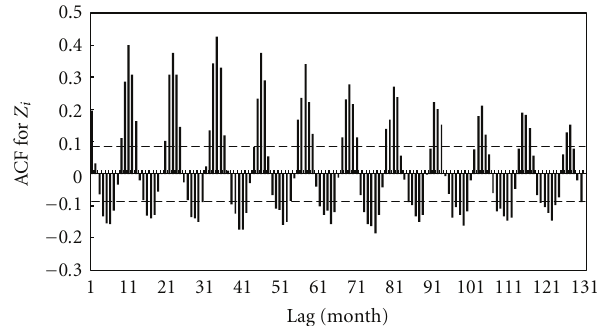
Table 1: Estimated coe ffi cients for rainfall model s ( t ) with n =